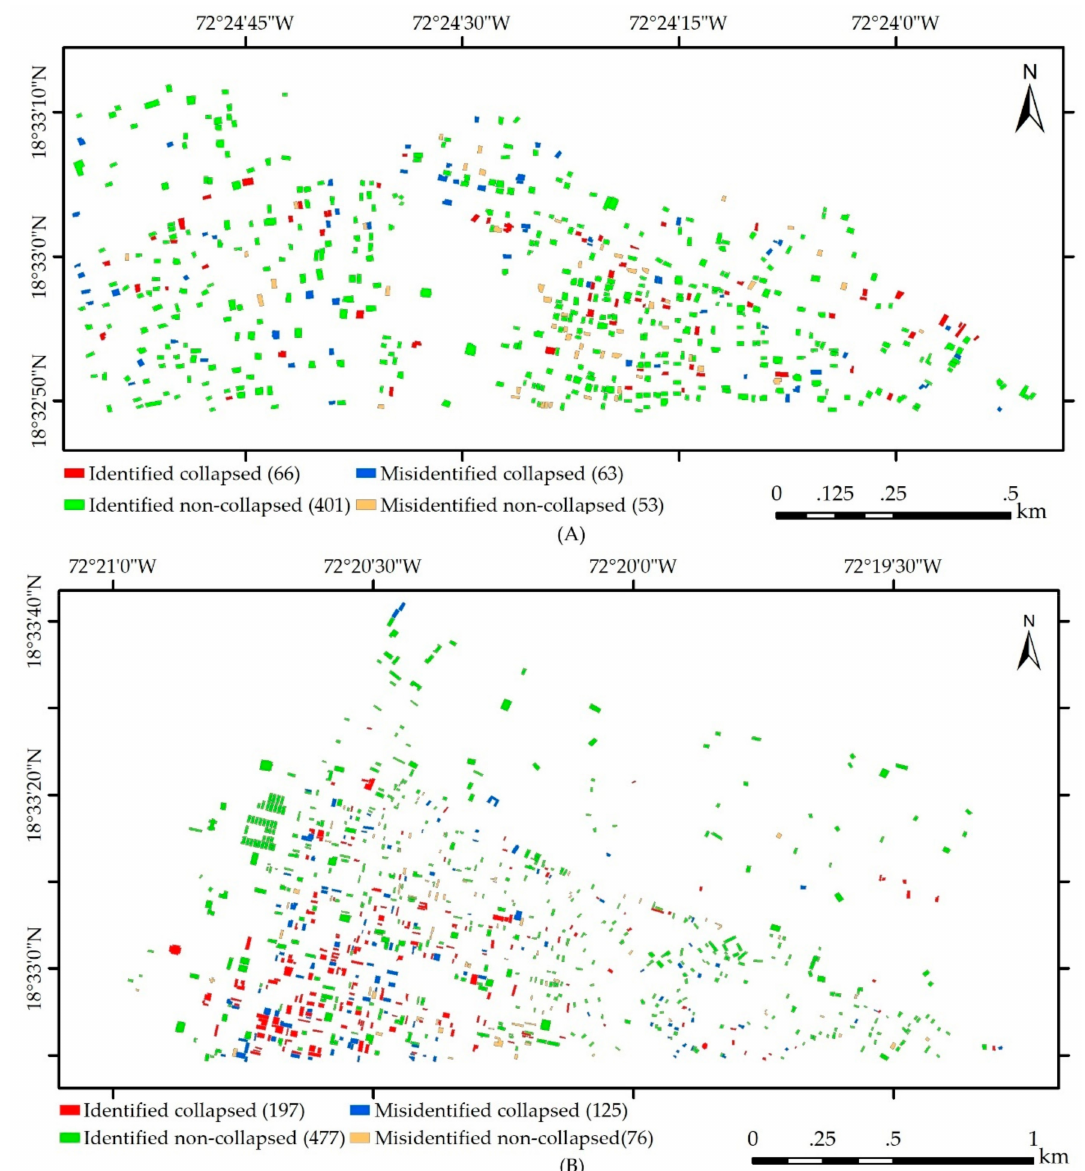
Figure 8. The performance of the balanced-CNN on identifying collapsed buildings using test A ( A ) and test B ( B )